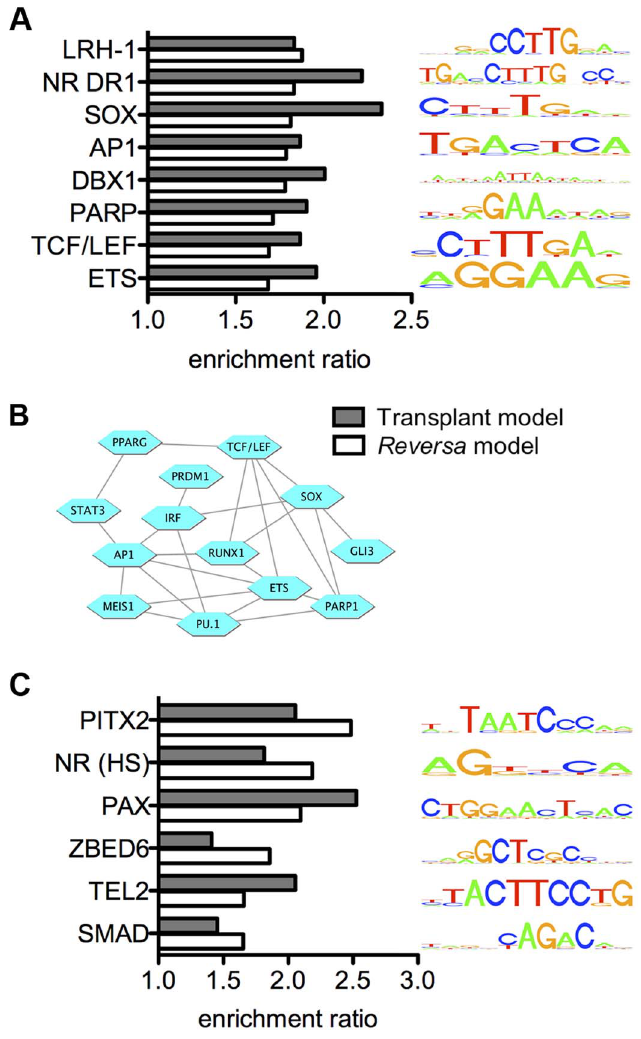
Figure 3. Integrated analysis reveals candidate regulators of the macrophage transcriptional response to lipid lowering invivo . (A) Transcription factor binding site motifs whose matches are statistically overrepresented within 5 9 regulatory regions of genes that are upregulated in plaque macrophages in response to lipid lowering in vivo . Bars indicate the ratio of the number matches of the indicated motifs per kbp, within an upregulated gene set, to the number of motif matches per kbp for randomly selected sets of genes expressed in CD68 + cells. Bar color indicates the regression model: white, Reversa model; gray, aortic transplant model. Only motifs for which the ratio exceeds 1.5 (with a statistical significance of P , 0.01) in both models are shown (complete list in Table S9). Motifs are labeled by the transcription factor family name with which they are associated (motif IDs are provided in Table S9). Each motif is represented by a four-color motif logo. (B) The transcription factors that are associated with upregulated genes are highly interconnected at the level of protein-protein interaction network . Blue hexagons represent transcription factors or transcription factor families, and edges denote protein-protein interactions between them. (C) Transcription factor binding site motifs whose matches are statistically overrepresented within 5 9 regions of genes that are downregulated in plaque macrophages in response to lipid lowering in vivo . ‘‘NR (HS)’’, nuclear receptor half-site. analysis using high-precision motifs based on three-dimensional structural modeling of protein-DNA interactions [61] (Table S9).